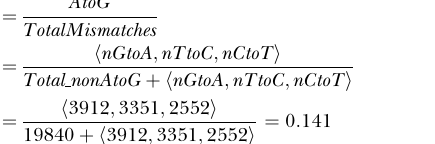
Table S1. Database of Computationally Identified Editing